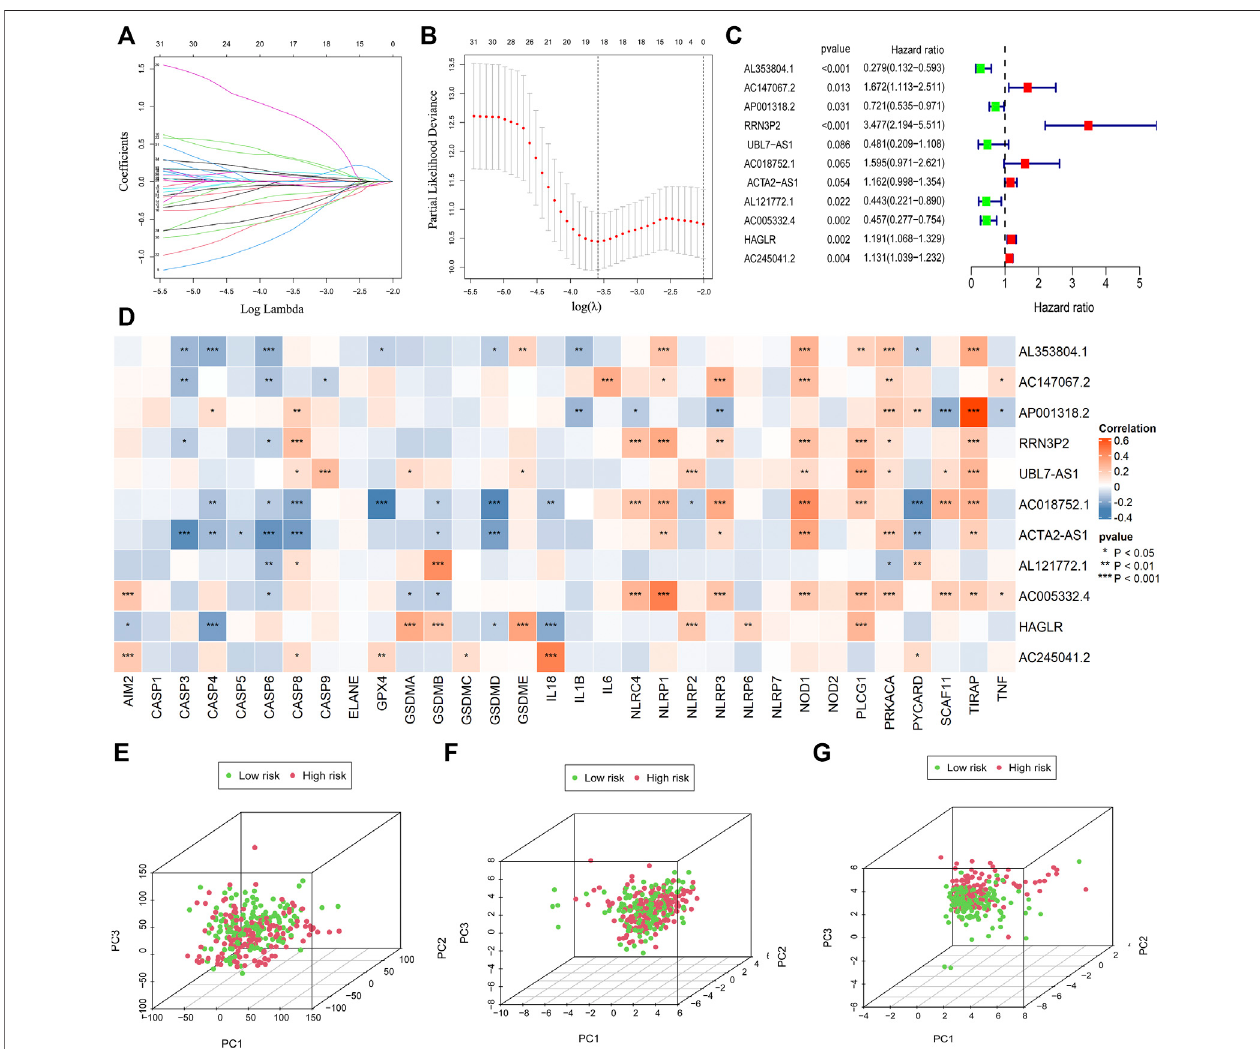
FIGURE2| Establishmentoftheriskmodel. TheLASSOandmulti-coxanalysiswereperformedtoconstruct theriskmodel (A – C) .11pyroptosis-related lncRNAs werescreenedfortheconstructionoftheriskmodel (C) .Thecorrelationbetween33pyroptosisgenesand11lncRNAsintheriskmodelwasvisualized (D) .PCAanalysis was conducted for the entire gene set (E) , 33 pyroptosis genes (F) , and 11 pyroptosis-related lncRNAs in the risk model (G) .